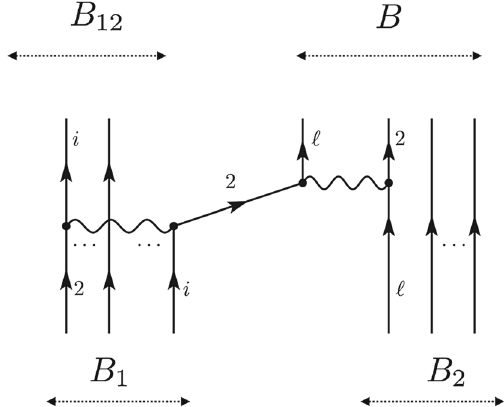
Fig. 6 Feynman diagrams for the dibaryon decays into N − 1 baryons, D → ( N − 1 )